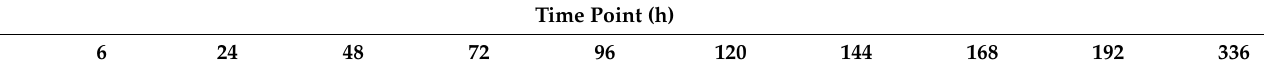
Table 1. Cell cycle distribution in LS-174T intraperitoneal (i.p.) tumor xenografts following treatment with 177